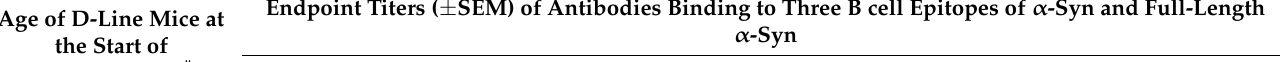
Table 1. PV-1950R/A adjuvanted protein vaccine is immunogenic in young and aged D line mouse model of